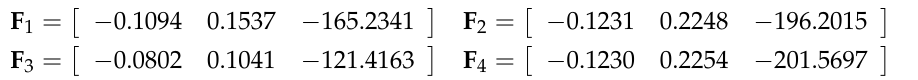
algorithm (21) through MATLAB’s LMI toolbox [24], the fuzzy state feedback gains are